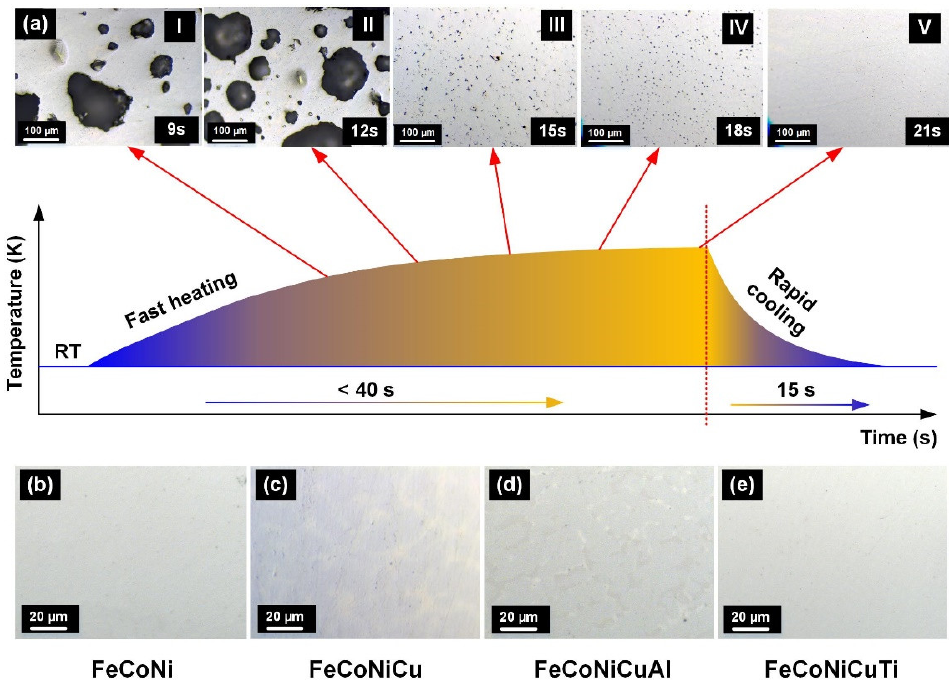
Figure 5. Rapid synthesis of alloys. ( a ) The temperature profile of CuNi alloy using the RF-ICP synthesis. The OM images demonstrate the evolution of the porosity of CuNi alloy during the HEA synthesis process. ( b – e ) OM images of synthesized FeCoNi MEA, FeCoNiCu MEA, FeCoNiCuAl HEA, and FeCoNiCuTi HEA [17].